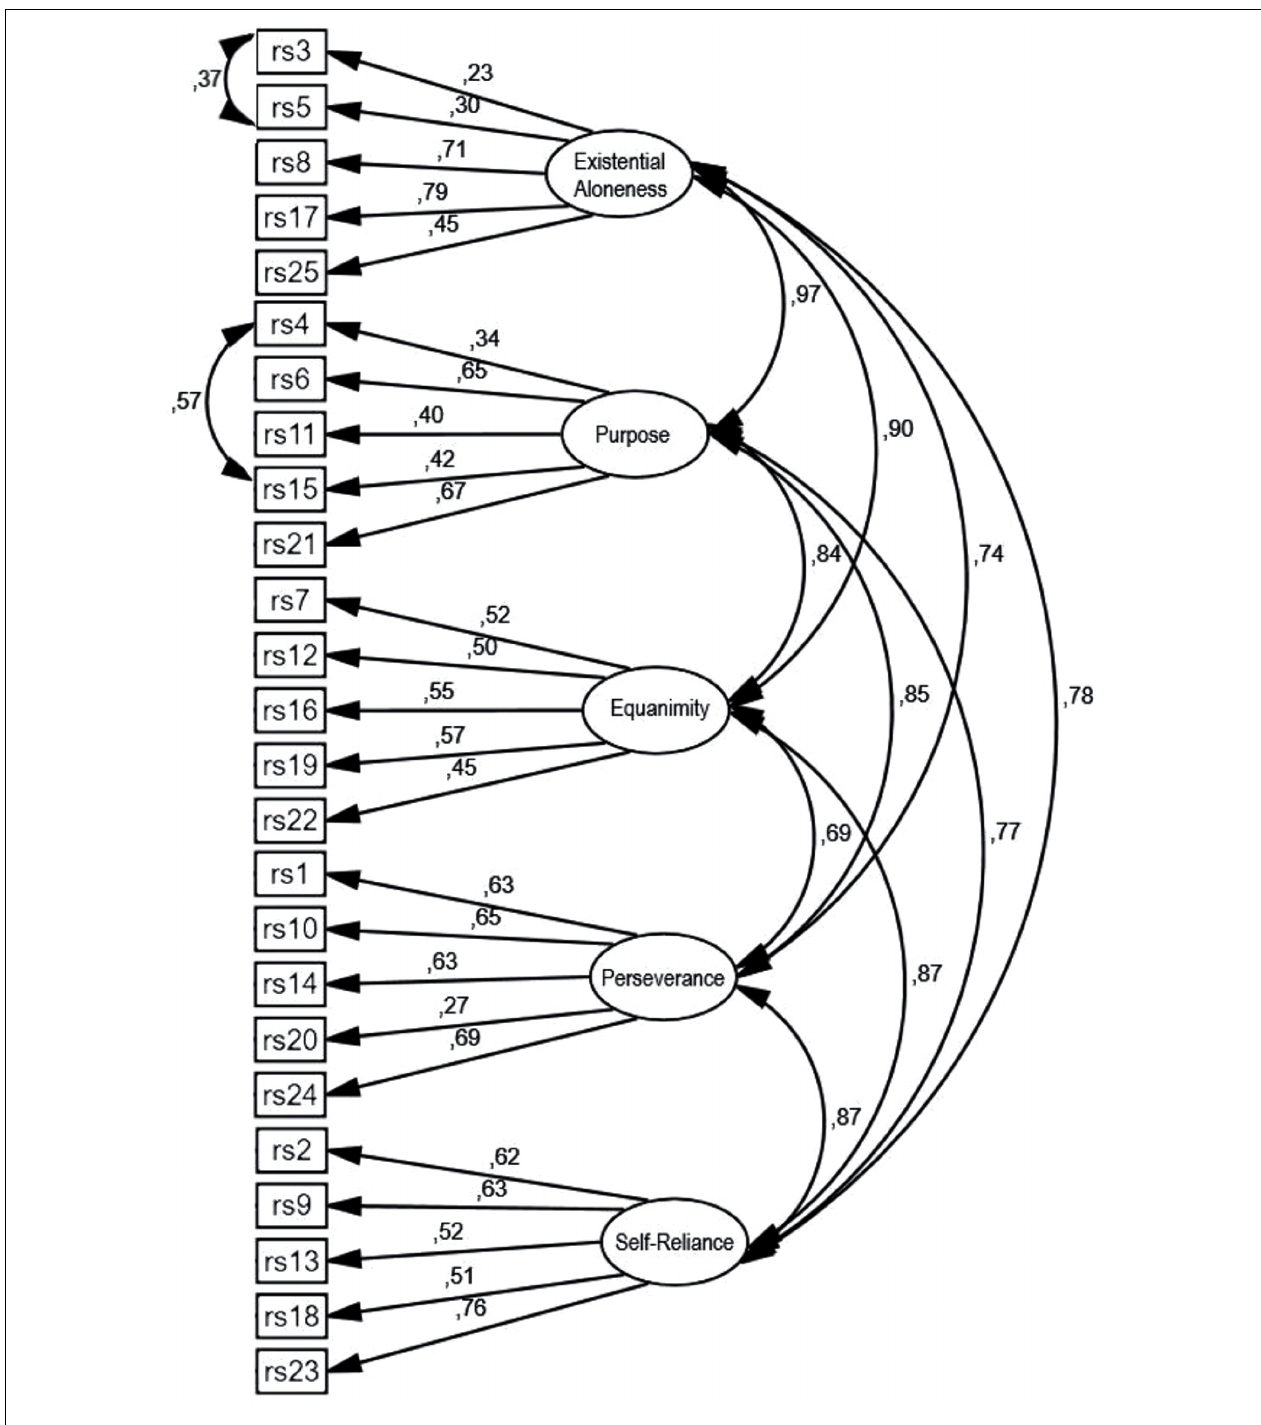
FIGURE 1 | Five-factor resilience model with two modifications.